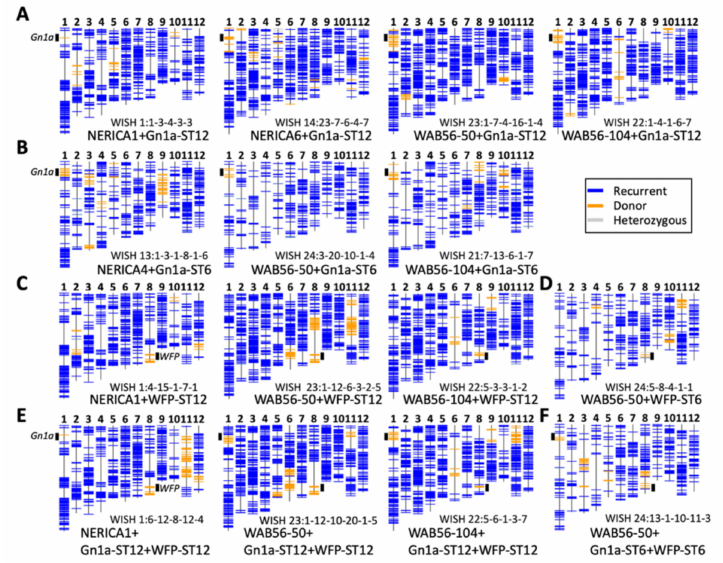
Figure 2. Marker genotypes of the representative lines. Genotypes of GBS markers are represented with horizontal color lines. Chromosomes and marker positions are drawn to scale of physical lengths, and positions of Gn1a and WFP are shown in short bold black lines. ( A ) Selected lines with Gn1a-ST12 , ( B ) selected lines with Gn1a-ST6 , ( C ) selected lines with WFP-ST12 , ( D ) selected lines with WFP-ST6 , ( E ) selected lines with Gn1a-ST12 + WFP-ST12 , ( F ) selected line with Gn1a-ST6 + WFP-ST6